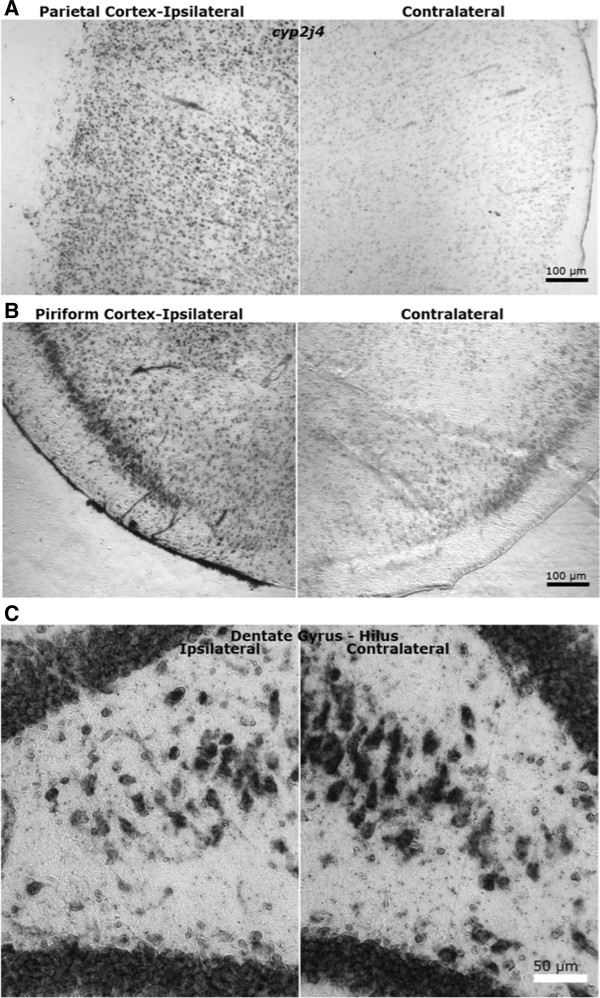
In situ hybridization histochemistry for rat Cyp2j4 mRNA in brain 7 days after TBI. Representative fields of injured and contralateral (A) parietal cortex; (B) piriform cortex; (C) hippocampal dentate gyrus. Note the apparent loss of pyramidal neurons in the ipsilateral dentate hilar region. Little staining was observed in the corpus callosum or other white matter structures. Some microvascular profiles appeared to stain positive in these non-perfused fresh frozen brain sections. Studies were carried out starting anterior to the site of injury, staining every sixth section through the injured volume (bregma −1.8 mm to approximately −4.5 mm, according to the coordinates of Paxinos and Watson [155]). High stringency hybridization and washes were performed as described in Section In situ hybridization histochemistry.